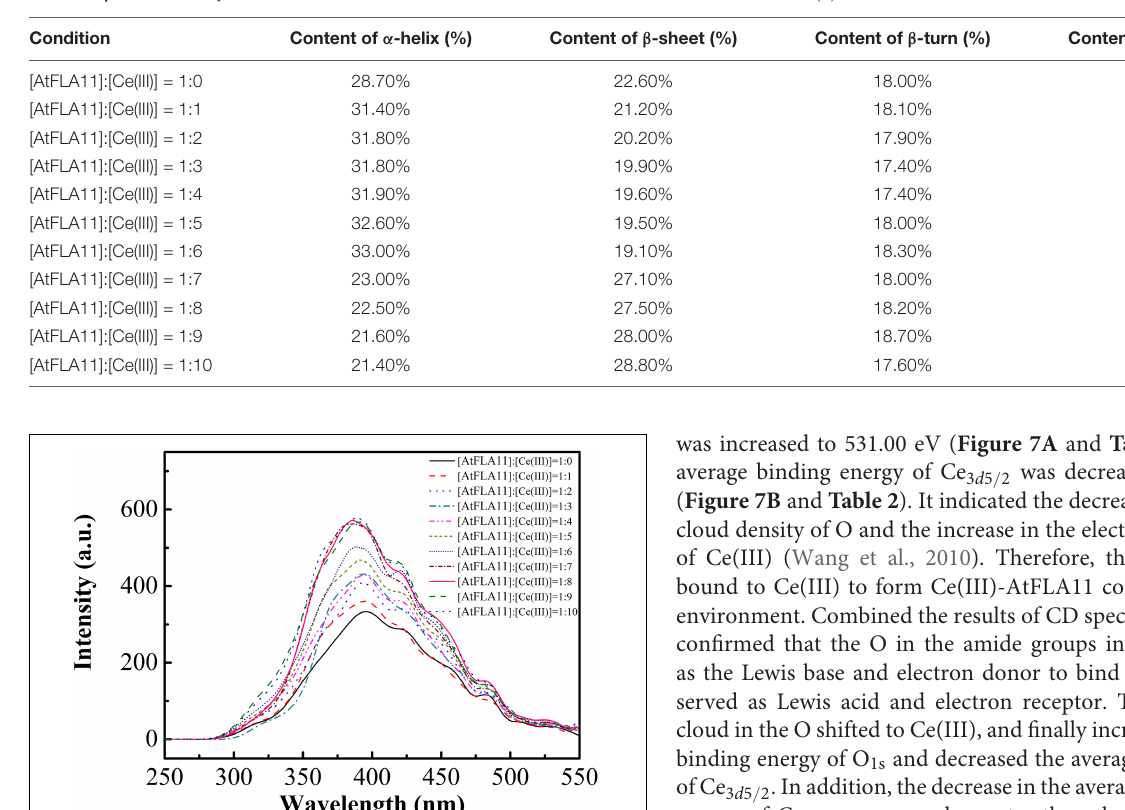
TABLE 1 | The secondary structure information of AtFLA11 incubated with different concentrations of Ce(III).